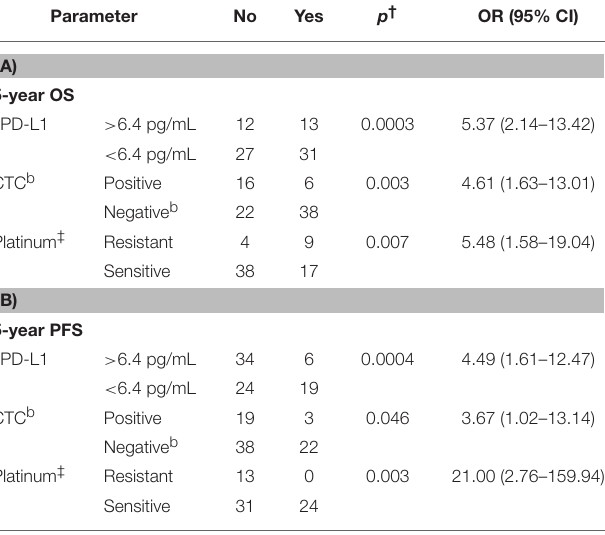
TABLE 2 | Association of sPD-L1, CTCs, and platinum-resistance/sensitivity status of EOC Patients with 5-year overall survival (OS) (A) and progression-free survival (PFS) (B)